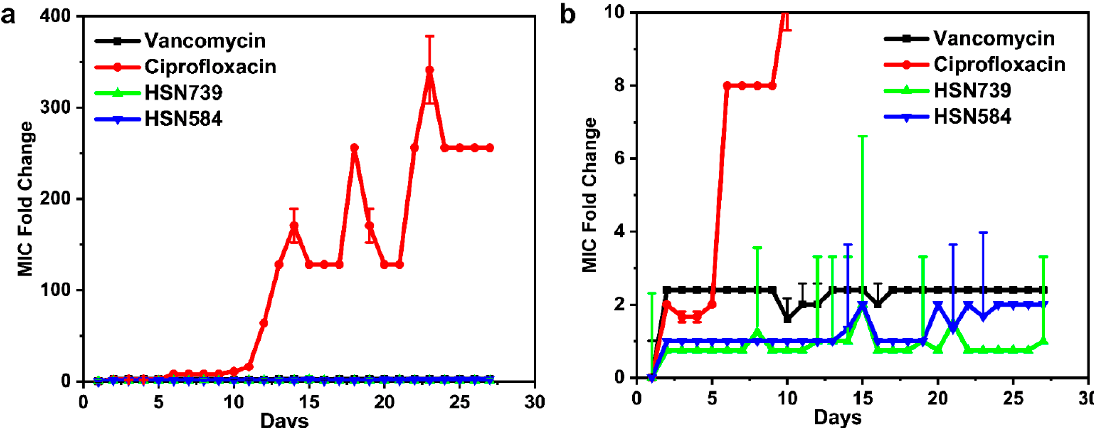
Figure 7. Multistep resistance study. ( a ) Multistep resistance study of vancomycin, ciprofloxacin, HSN584 and HSN739 against S. aureus ATCC 25923. ( b ) Magnified version of part a. S. aureus was serially passaged over a period of 27 days and the broth microdilution assay was used to determine the MIC of each compound after each successive passage.